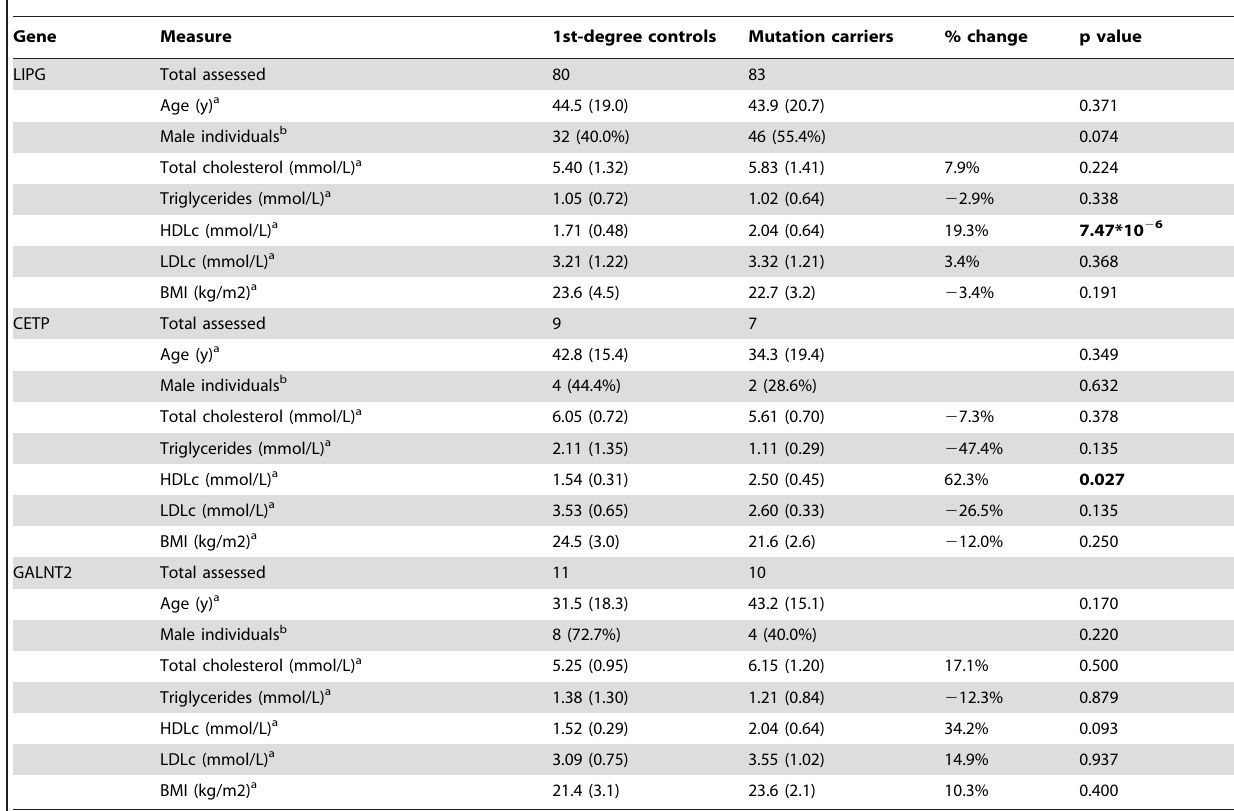
Table 4. Phenotypes of family members with single LIPG, CETP, and GALNT2 mutations.